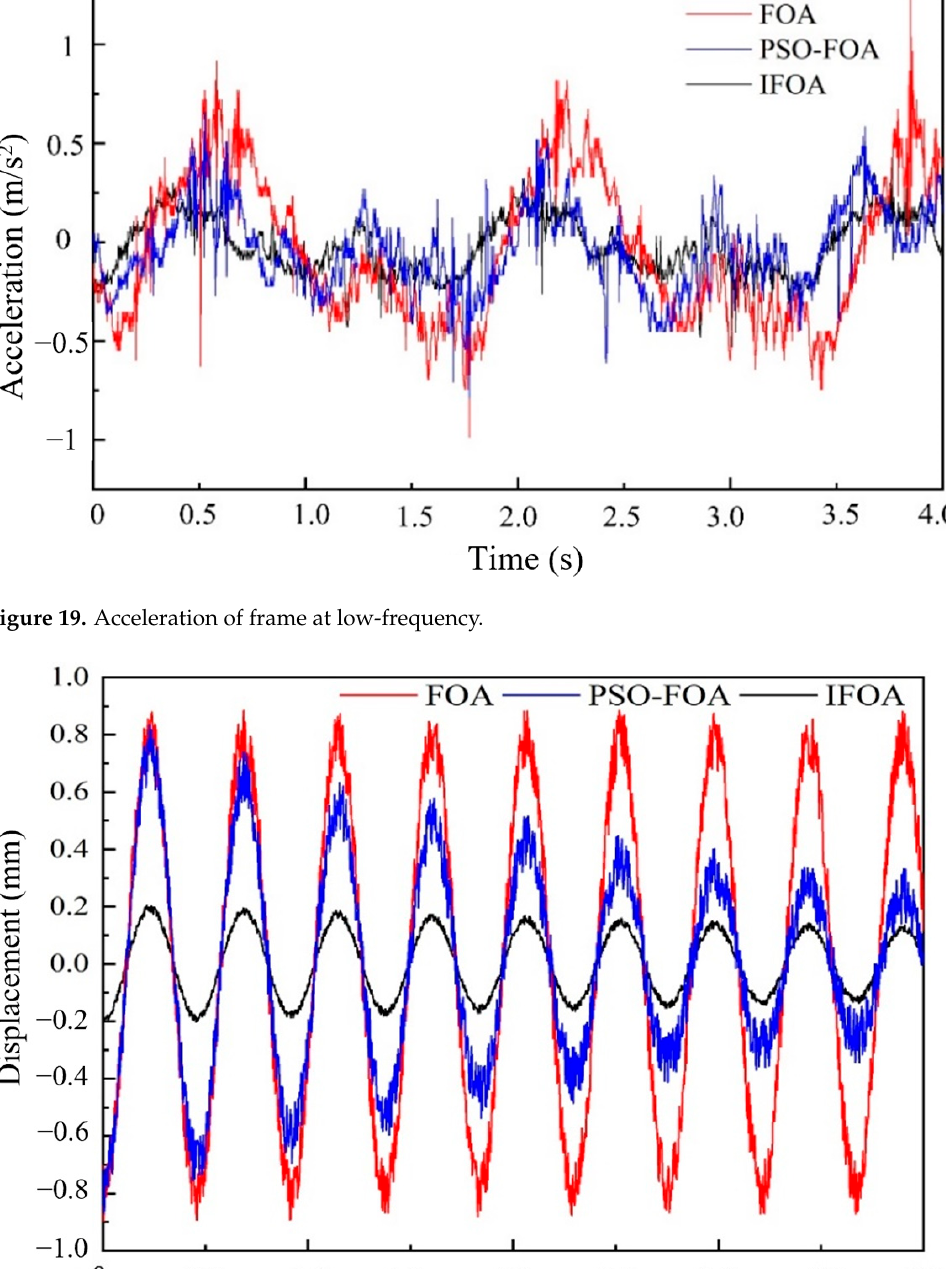
Figure 21. Acceleration of frame at high-frequency. Figure 22. Displacement of frame t at high frequencies.